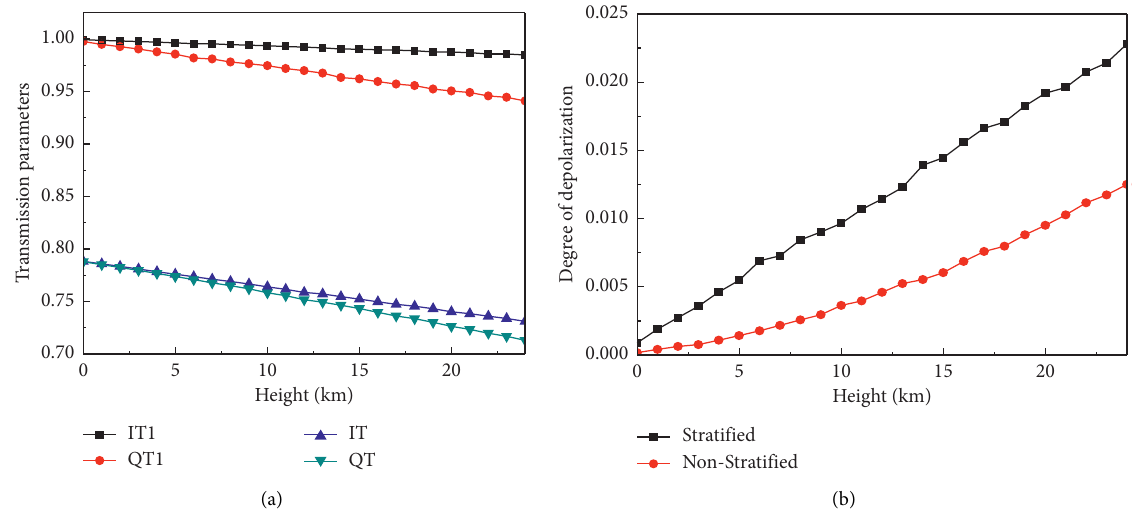
Figure 8: Variation of polarization parameters (stratified and nonstratified) with height ( b � 0.25 μ m).